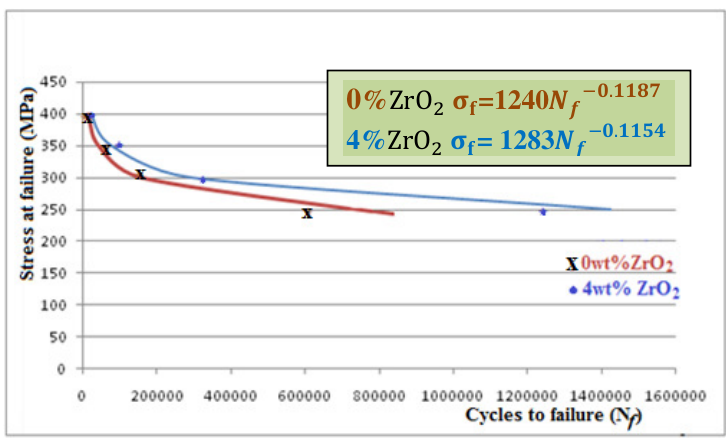
Fig. 6. S-N curves of the Nano composite with 4 (cid:11) (cid:20) % ZrO 2 compared with the base metal 7049AA with 0% ZrO 2 under constant amplitude stress .